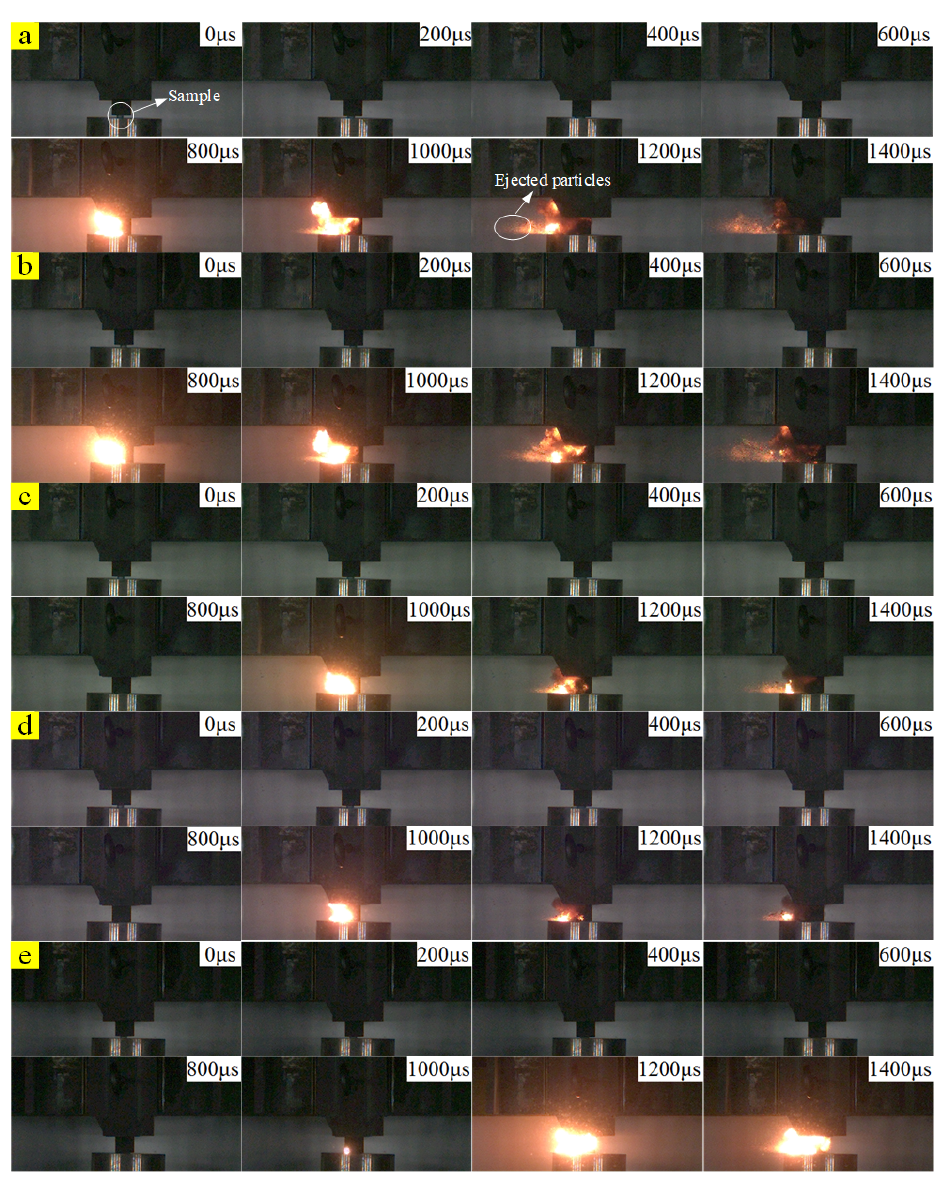
Figure 3. The high-speed video frames of drop-weight tests. ( a ) Sample temperature is 25 °C and drop height is 155 cm, ( b ) sample temperature is 100 °C and drop height is 145 cm, ( c ) sample temperature is 200 °C and drop height is 100 cm, ( d ) sample temperature is 300 °C and drop height is 80 cm, and ( e ) sample temperature is 350 °C and drop height is 75 cm.